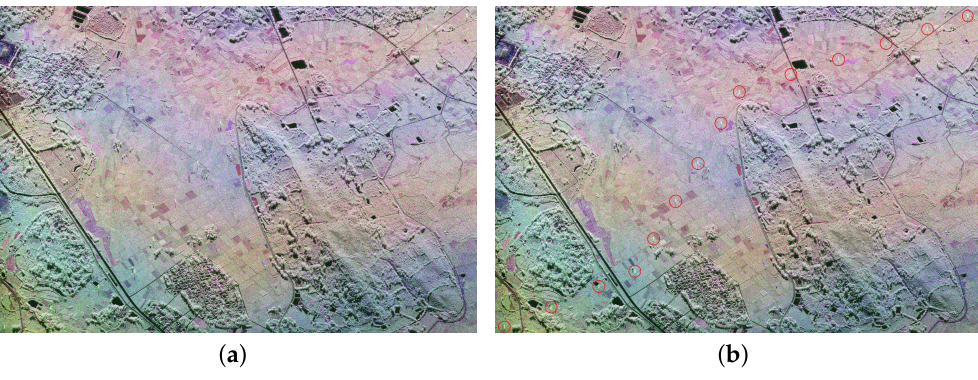
Figure 13. Pauli color coded image of Linshui City in Hainan Province. ( a ) original PolSAR image; and ( b ) marked